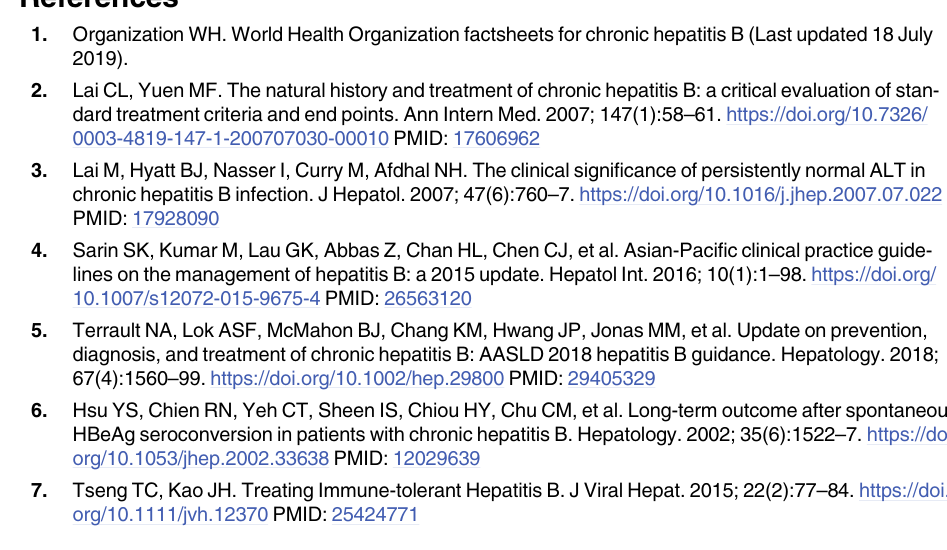
S1 Table. Baseline clinical characteristics of the patients who had not received interferon treatment among different phases of chronic hepatitis B virus infection. S2 Table. Baseline clinical characteristics of the patients in CH and LC groups according to the development of hepatocellular